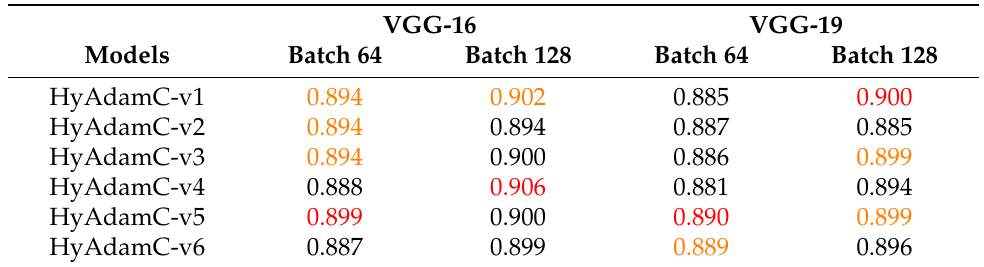
Table 3. The test accuracies of the VGG-16 and 19 trained by the six HyAdamC models. The first and second best results are highlighted in red and orange, respectively.